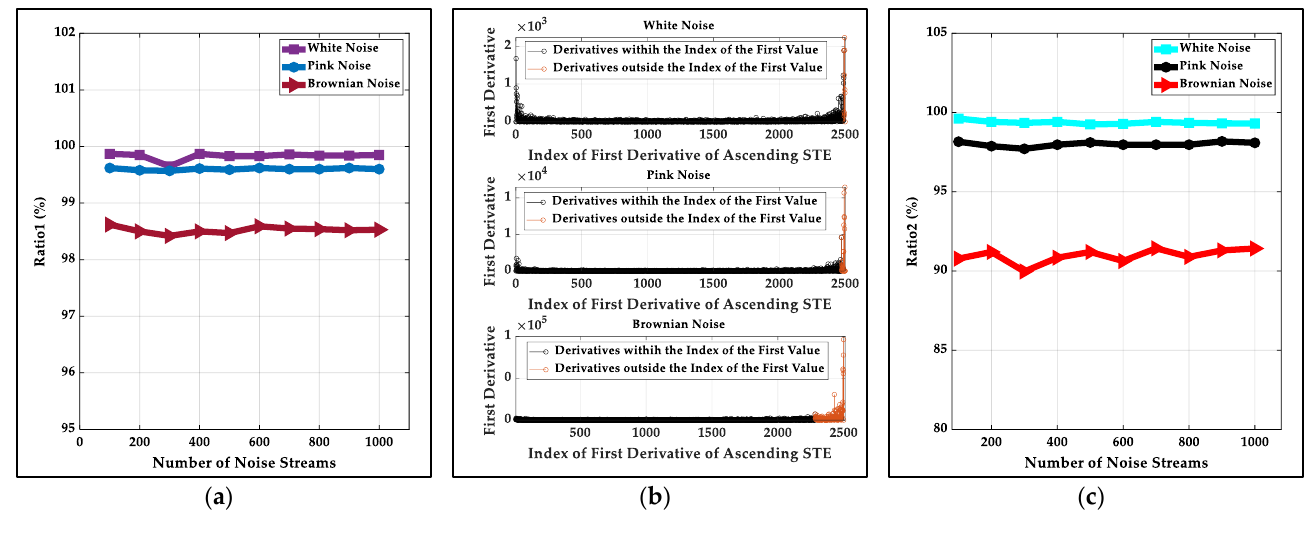
Figure 2. The characteristics of the first derivatives of three kinds of simulated noise’s ascending STE: ( a ) the statistical ratio (named Ratio1) of the first derivatives less than or equal to the maximum first derivative of the first half U-shape to all first derivatives; ( b ) the distribution of the first derivatives whose indexes are from 1 to the index of the first value; ( c ) the statistical ratio (named Ratio2) of the first derivatives whose indexes are from 1 to the index of the first value to all first derivatives.